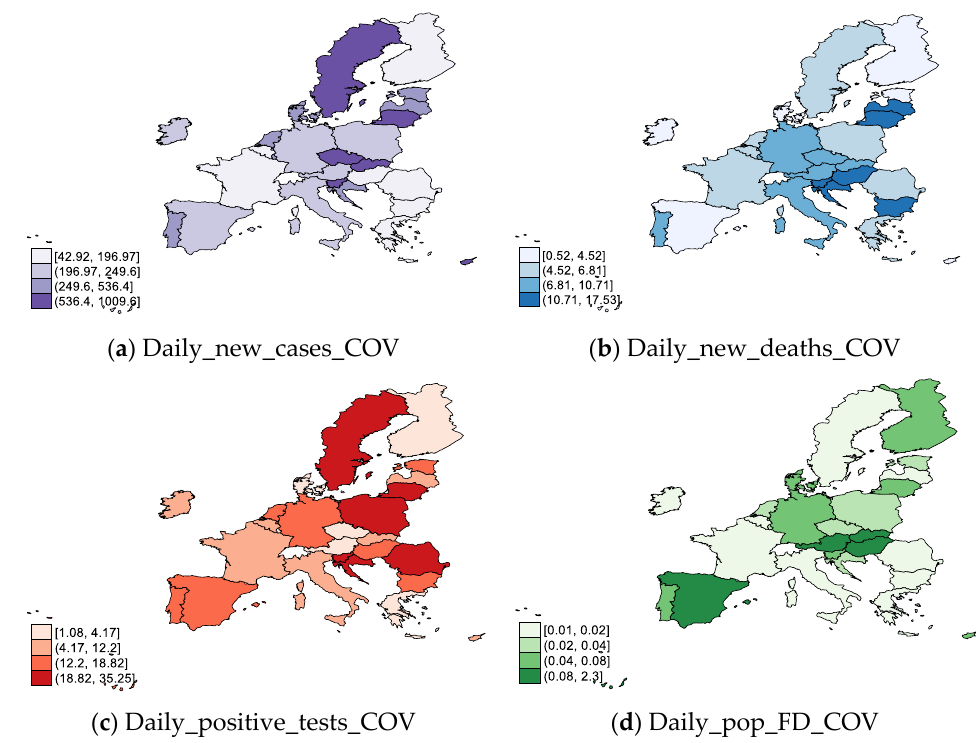
Figure 3. COVID-19 in EU-27, 2020 (31 December): ( a ) daily new cases; ( b ) daily new deaths; ( c ) daily positive tests; ( d ) daily share of the population receiving a first COVID-19 vaccine dose. Source: own process in Stata 17.